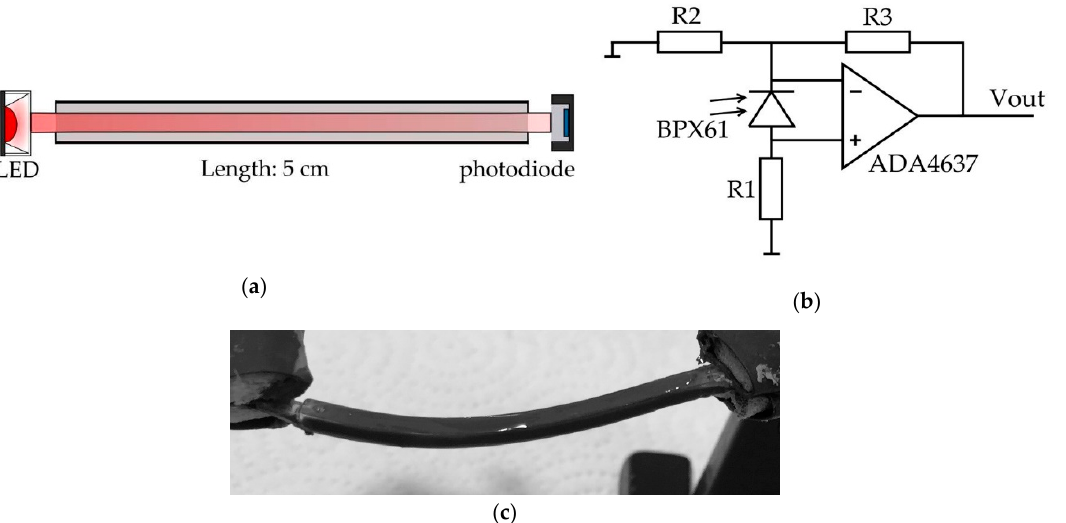
Figure 2. Measuring the deflection of the waveguide: ( a ) Schematic of the optical sensory system that comprises an LED, an optical waveguide and a photodiode [17]. ( b ) Photodiode amplifier [18]. ( c ) Fabricated PDMS waveguide consisting of three layers (core, cladding, sealing).